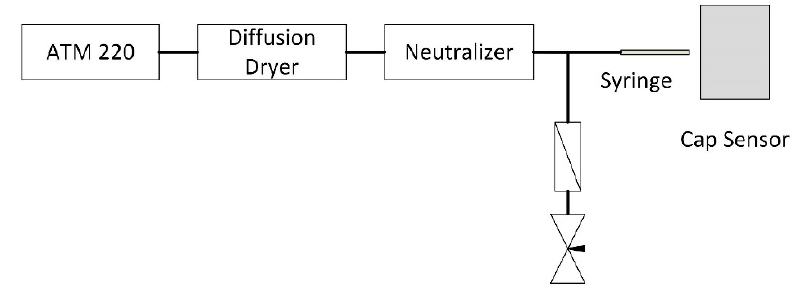
Figure 2. Setup for deposition of 1 µm PSL spheres onto the surface of the investigated capacitive sensor.